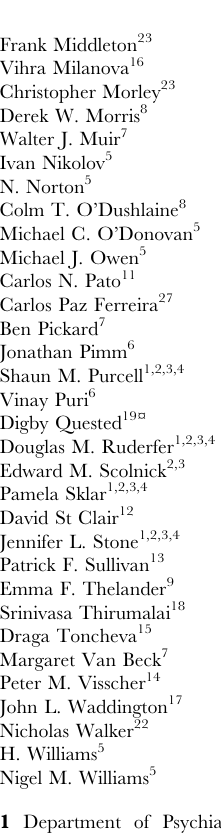
Table S7 Other promising regions in Crohn’s Disease GWA meta-analysis. Information about the top six regions identified by GRAIL from the next 75 most significant regions from the Crohn’s GWA study. All associations are indeterminate, and association p-values are taken from the GWA meta-analysis - these regions have not yet been replicated.